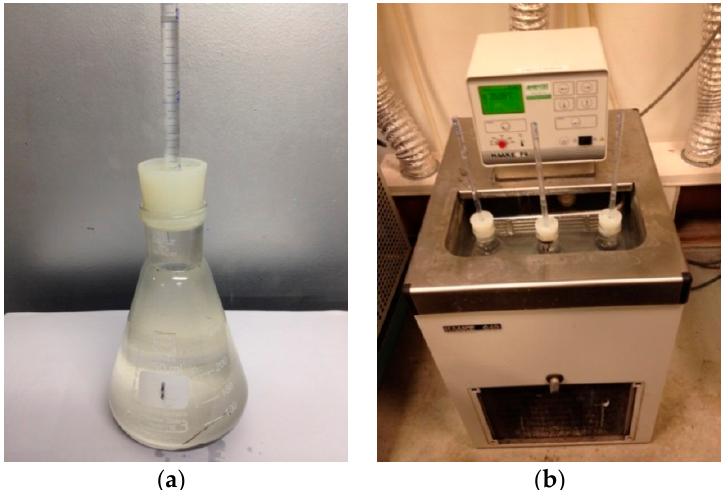
Figure 3. Equipment for chemical shrinkage measurement. ( a ) Glass Erlenmeyer flask with graduated tubes; ( b ) Constant-temperature water bath.